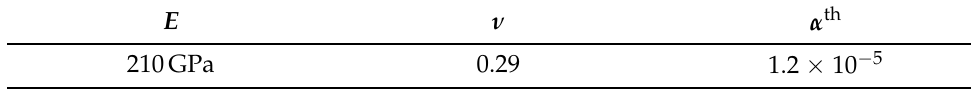
Figure 1. Evolution of the direct elastic coefficients as a function of the degree of cure ( a – c ). Due to the assumption of the transversal isotropy, the terms C 22 and C 33 are equal and C 12 and C 13 are equal. ( d , e ) Evolution of the effective transversal isotropic coefficient of chemical shrinkage (CCS) and coefficient of thermal expansion (CTE) as a function of degree of cure [10]. Table 1. Values of material parameters for the steel plate